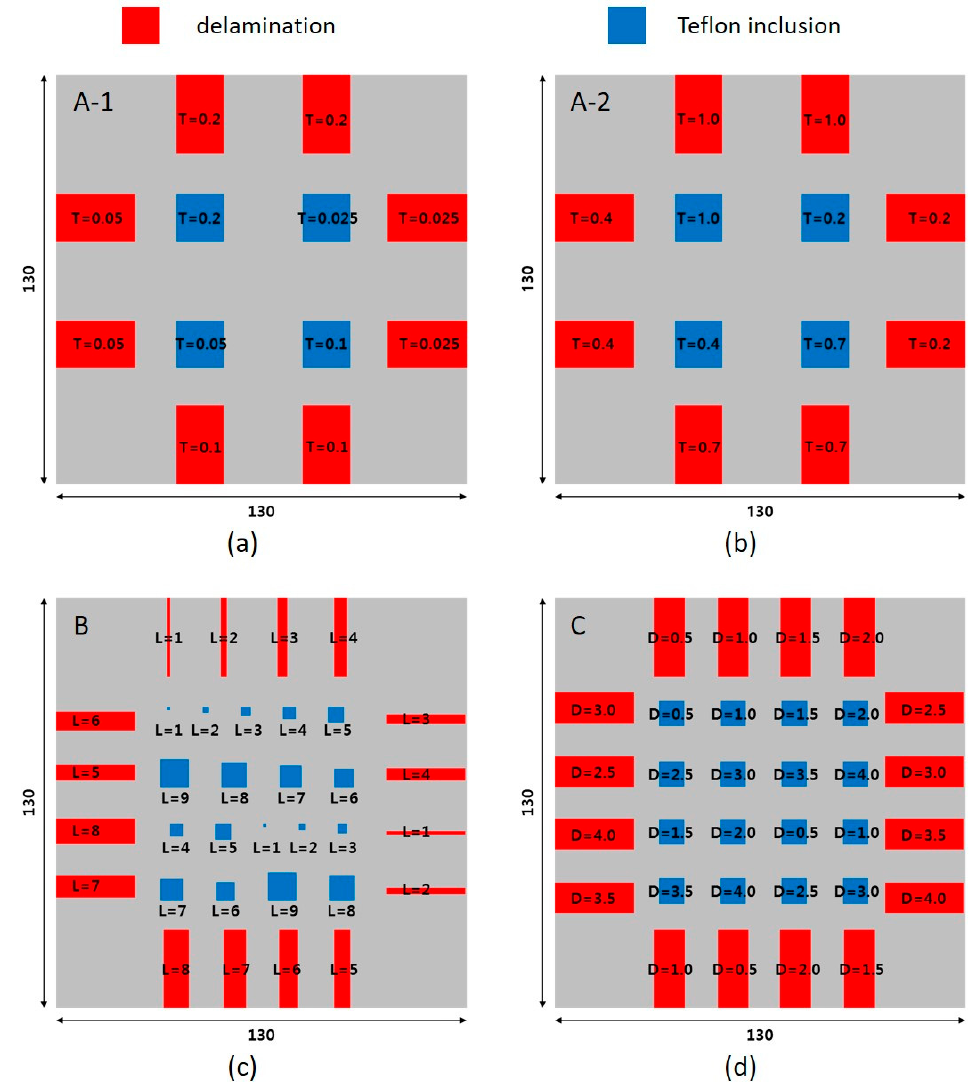
Figure 3. Schematic design of GFRP samples containing artificial internal defects with different ( a , b ) thicknesses, ( c ) sizes, and ( d ) locations in the depth direction. The numbers indicate millimeters.